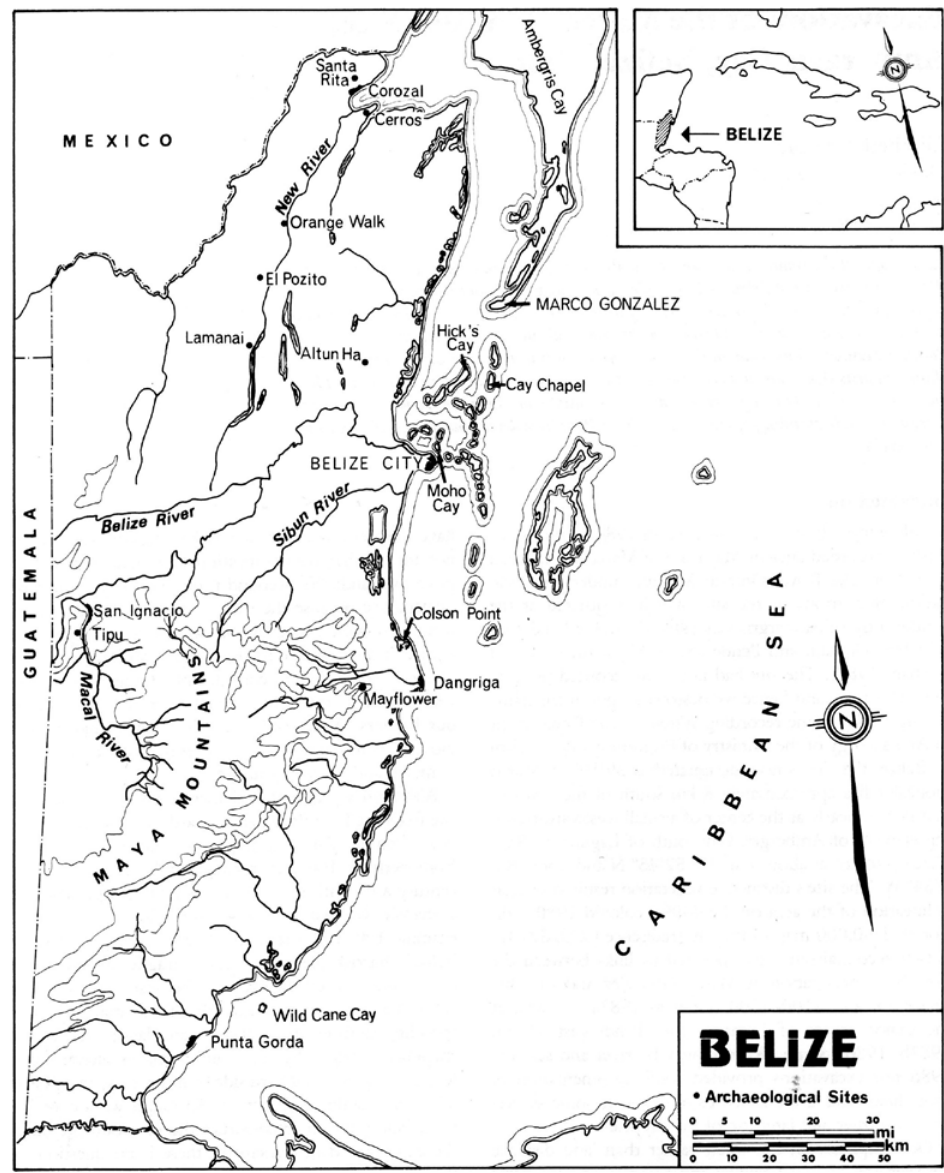
Fig. 1: Map of Belize showing the location of Marco Gonzalez on Ambergris